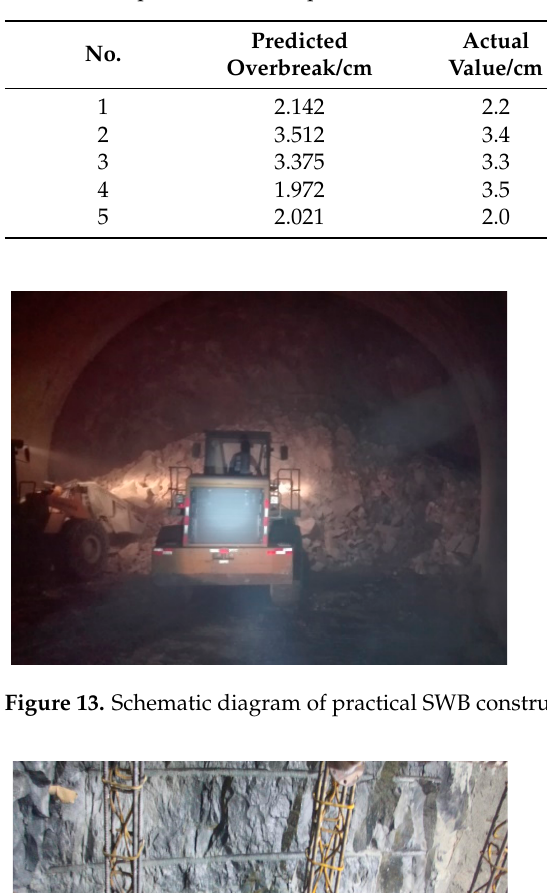
Table 7. Optimization calculation results.